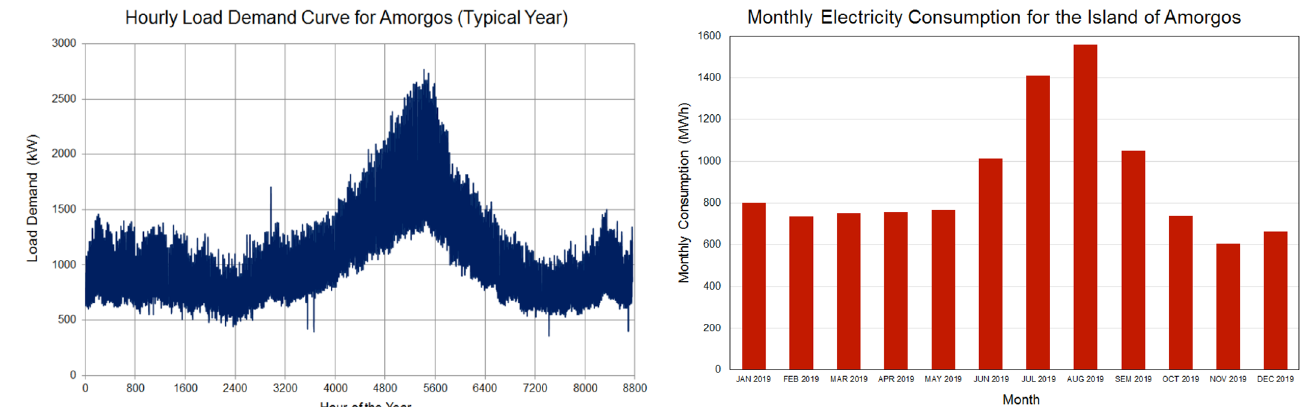
Fig. 3. The annual load demand of Amorgos island. Fig. 4. Amorgos island monthly energy consumption.